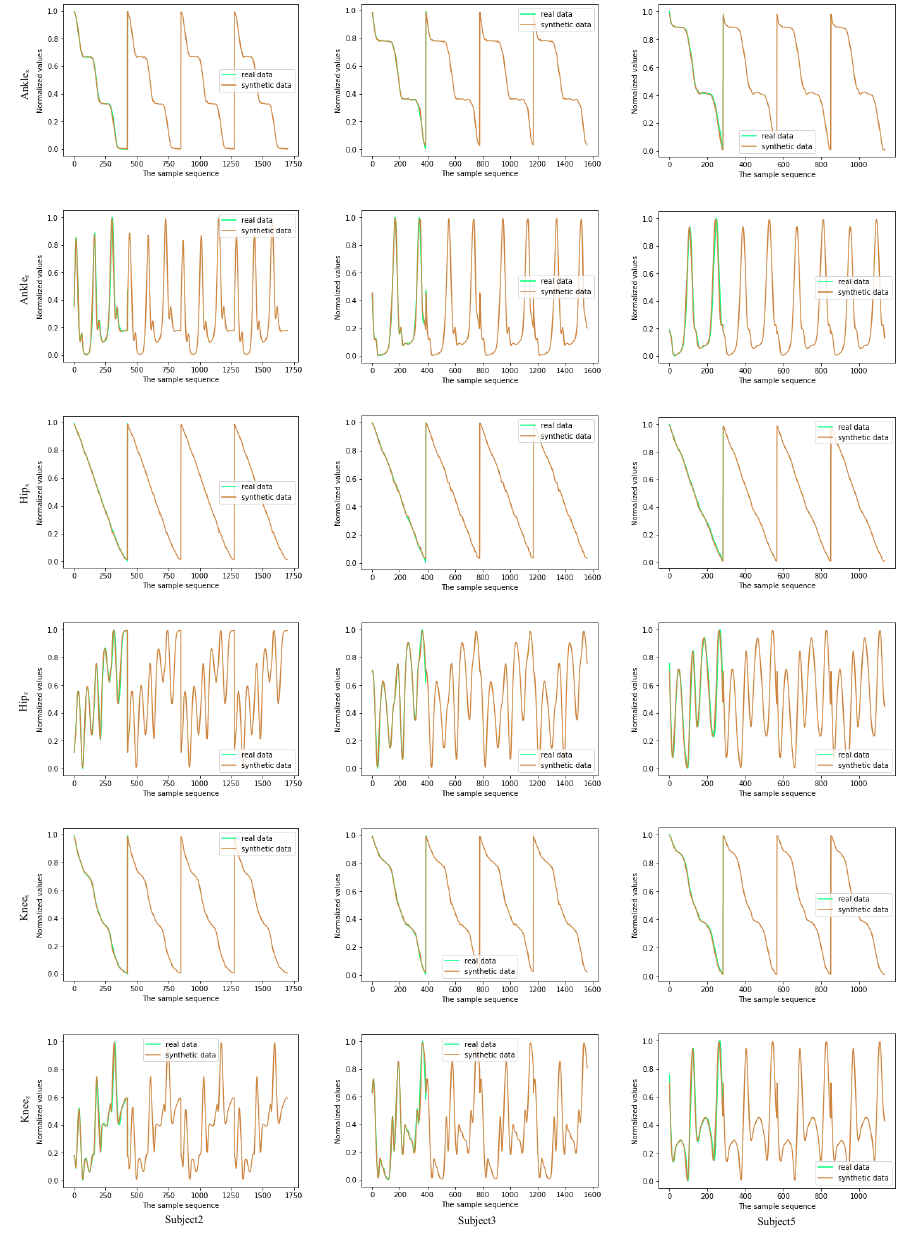
Figure 4. Augmented gait data from certain